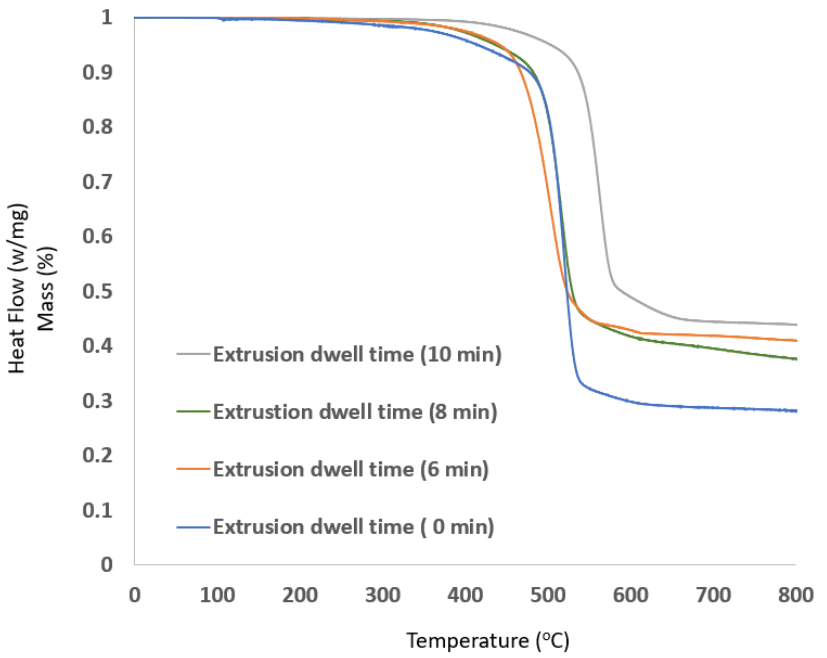
Figure 7. TGA curves for different extrusion dwell times for given LLDPE/MP blend. Table 6. Onset and final degradation temperatures for LLDPE/MP with extrusion dwell time .